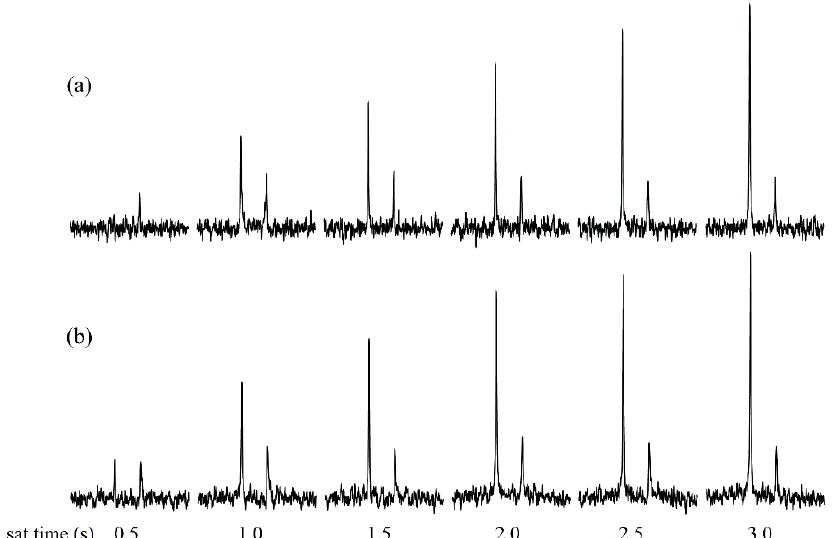
Figure 5. The 19 F{ 1 H} STD spectra acquired with various saturation times using ( a ) a rectangular pulse and ( b ) Gaussian shaped pulses for 1 H saturation.